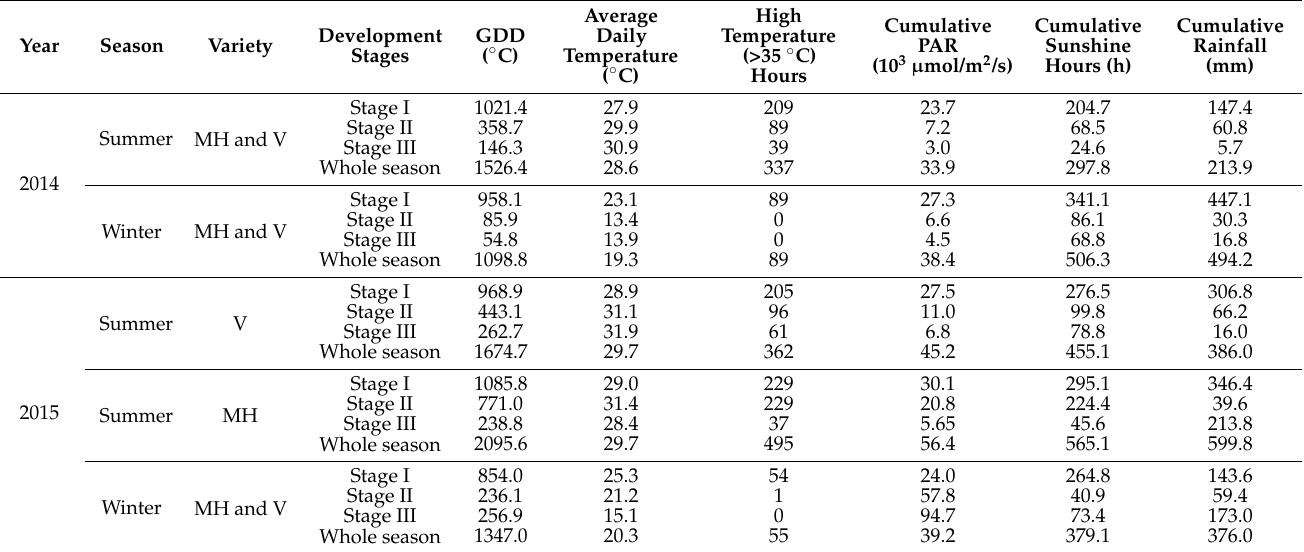
Table 1. Meteorological data in the growing seasons of ‘Muscat Hamburg’ and ‘Victoria’ grapes in 2014 and 2015.